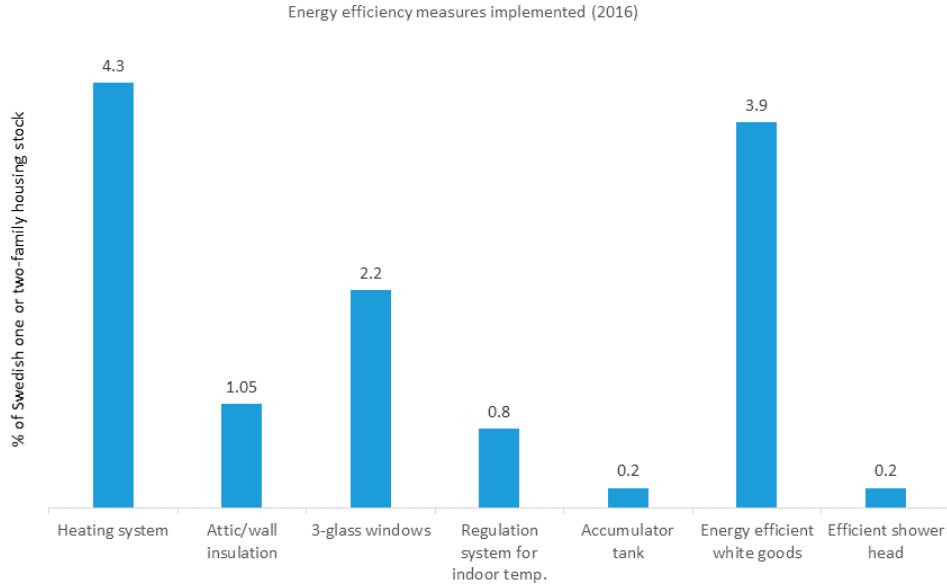
Figure 1. Average annual percentage of homeowners implementing different energy efficiency measures in Sweden (source: Swedish Energy Agency [8]).